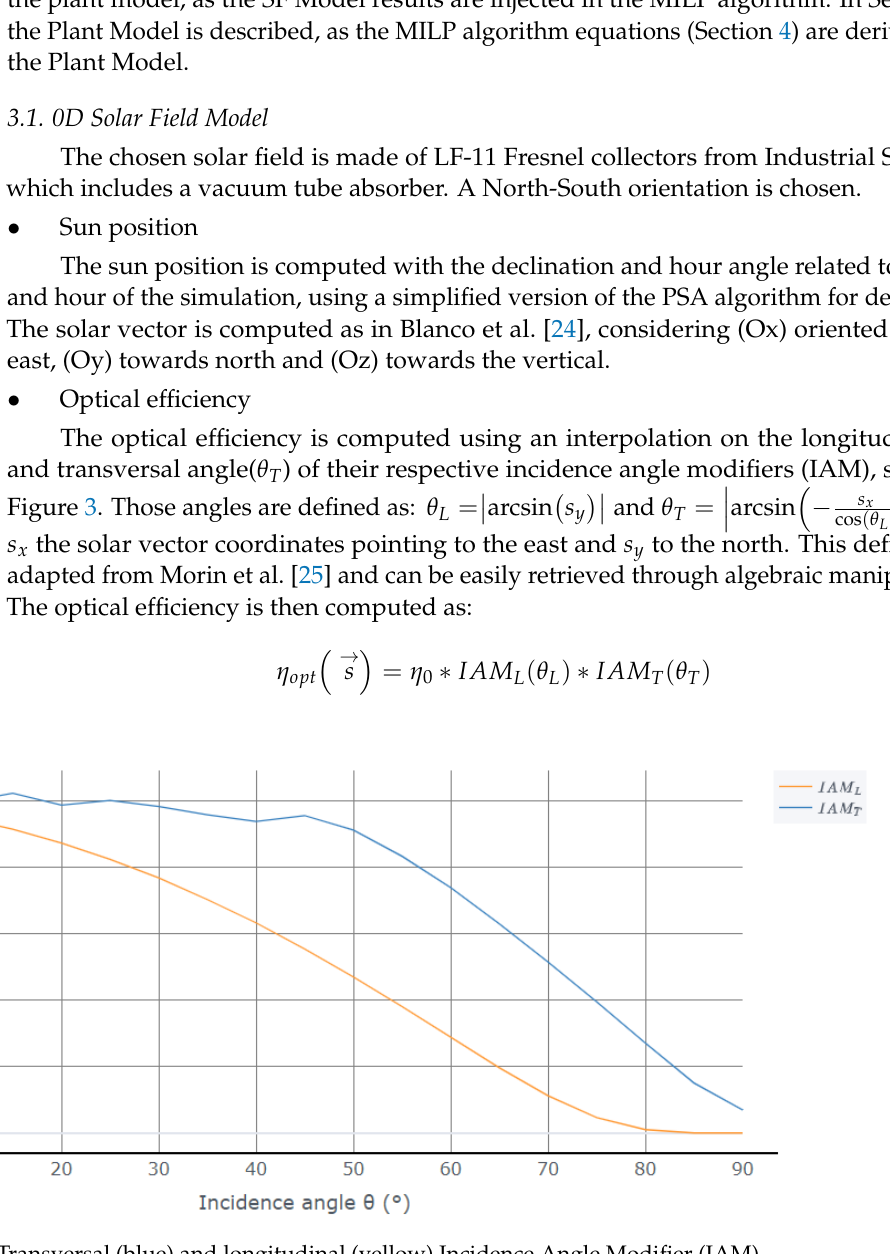
Figure 3. Transversal (blue) and longitudinal (yellow) Incidence Angle Modifier (IAM) .